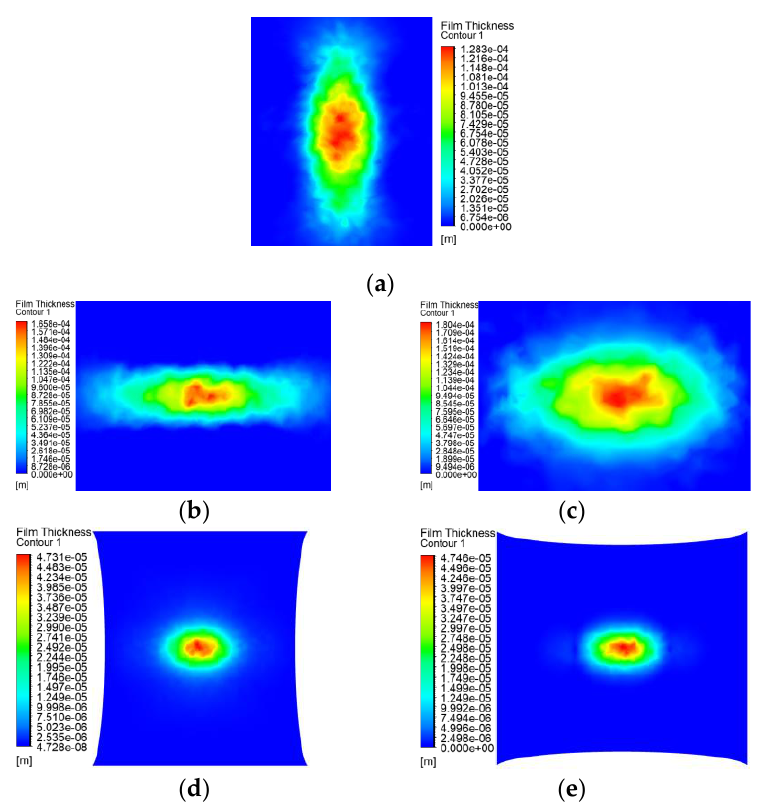
Figure 13. Film thickness of the static spraying. ( a ) Plane spraying. ( b ) Outer surface busbar spraying. ( c ) Circumferential spraying on the outer surface. ( d ) Spraying on the inner surface busbar. ( e ) Circumferential spraying on the inner surface.